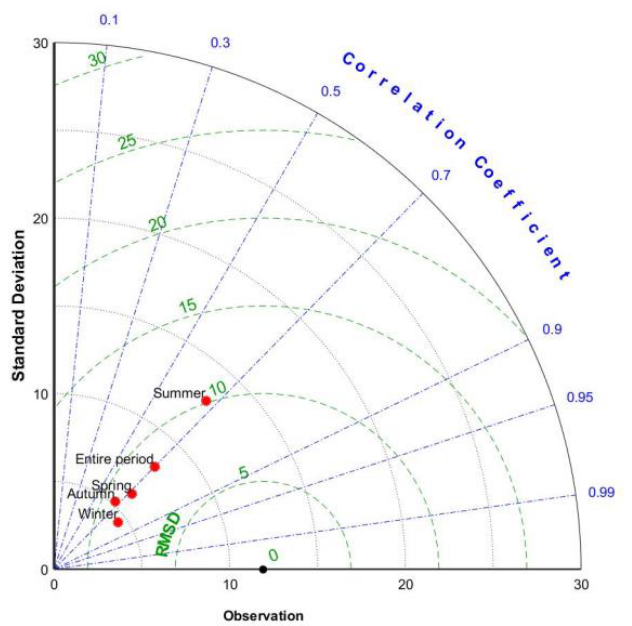
Figure 11. Taylor diagrams for the daily precipitation of the gauge observation and the GWR model across the entire period and different seasons in 2015.